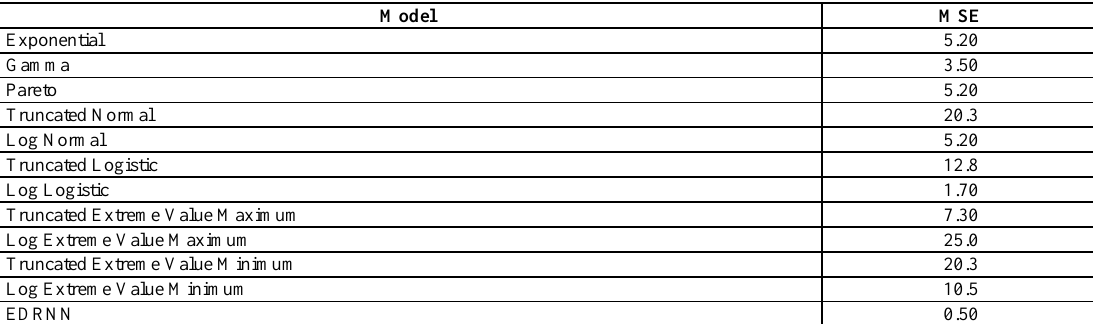
Table 4. MSE results of the proposed model and 11